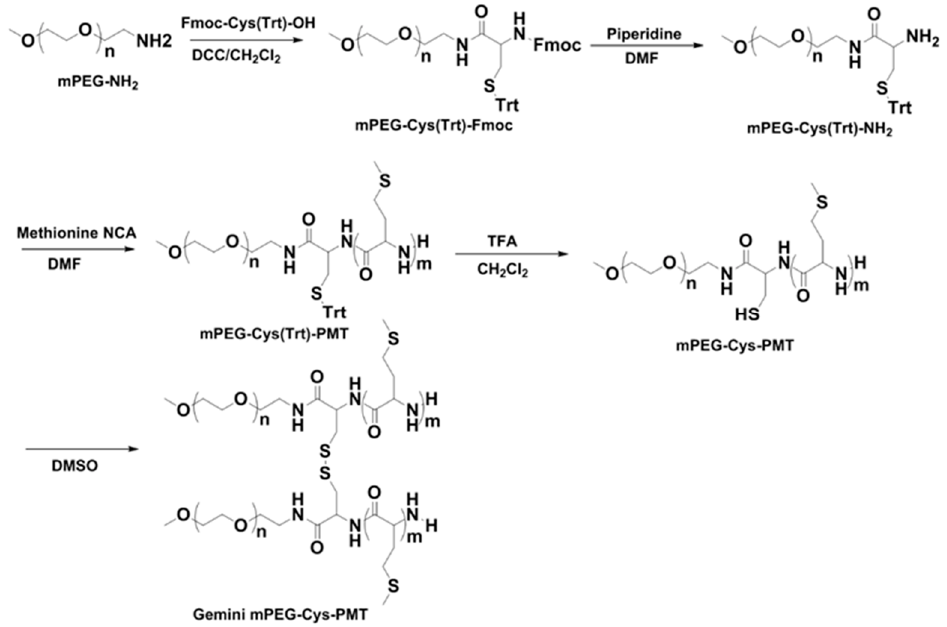
Figure 1. 1 H NMR spectra of gemini mPEG-Cys-PMT ( A ) and gemini mPEG-Cys-PMT oxidized in 0.1 mM H 2 O 2 for 12 h ( B